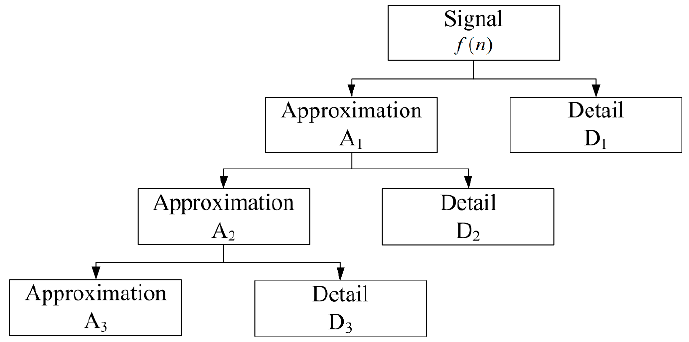
Figure 7. An example of a three-level wavelet decomposition of signal f ( n )